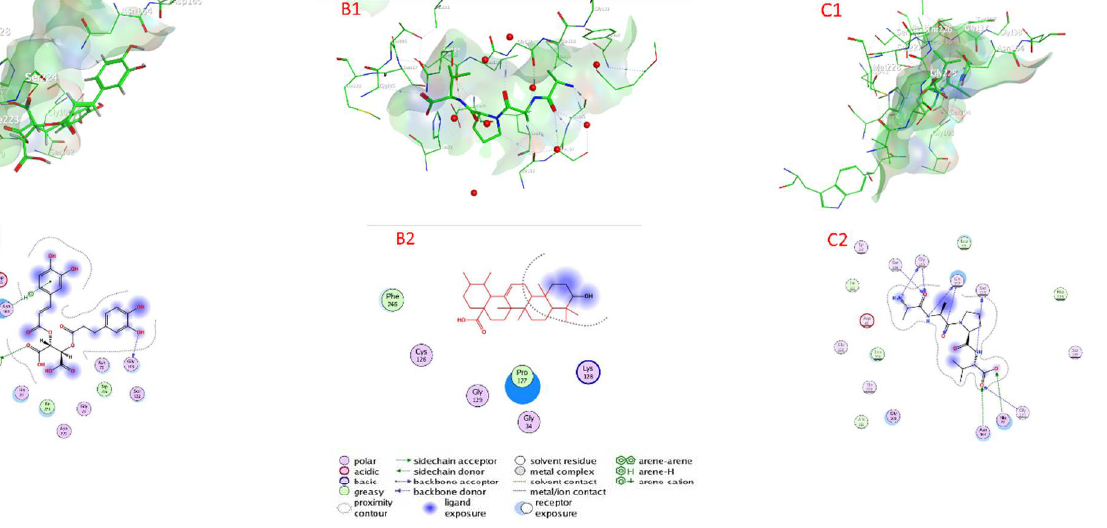
Figure 5. Docking view of ( A1 , A2 ) chicoric acid, ( B1 , B2 ) ursolic acid, and ( C1 , C2 ) salvigenin, in the binding sites of serine proteinase (PDB:2F7O); ( A1 , B1 , C1 ) 3D complex structures (stereoview) and ( A2 , B2 , C2 ) 2D interaction diagram structures.